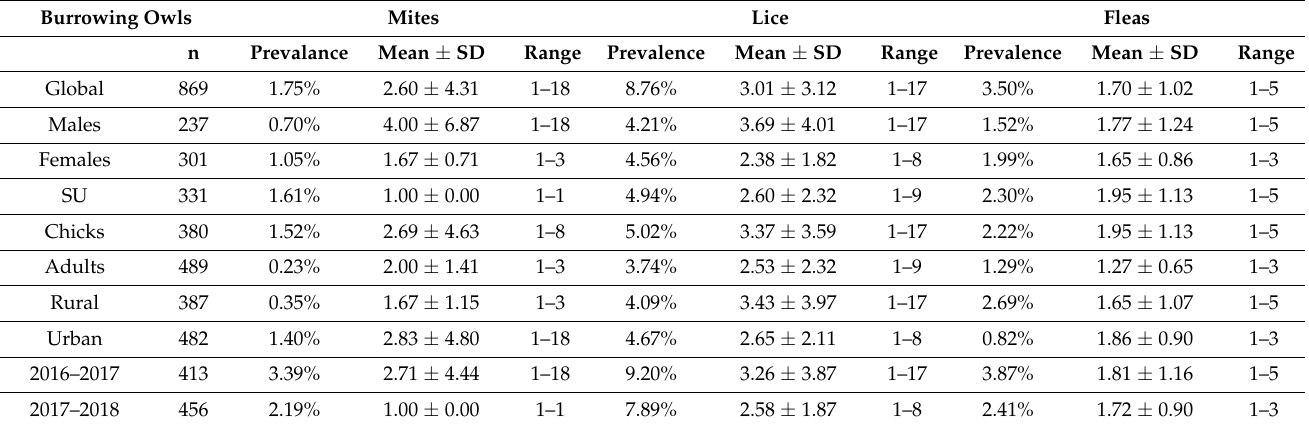
Table 1. Prevalence and abundance of ectoparasites found in rural and urban burrowing owls Athene cunicularia in Bah í a Blanca (Argentina). SD: standard deviation; SU: sex